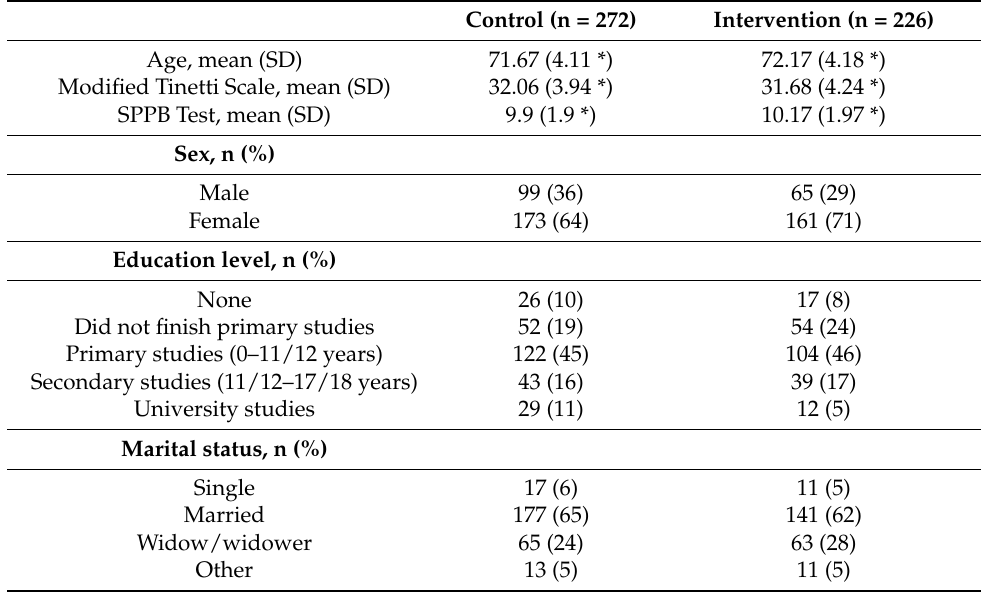
Table 1. Participants’ characteristics at